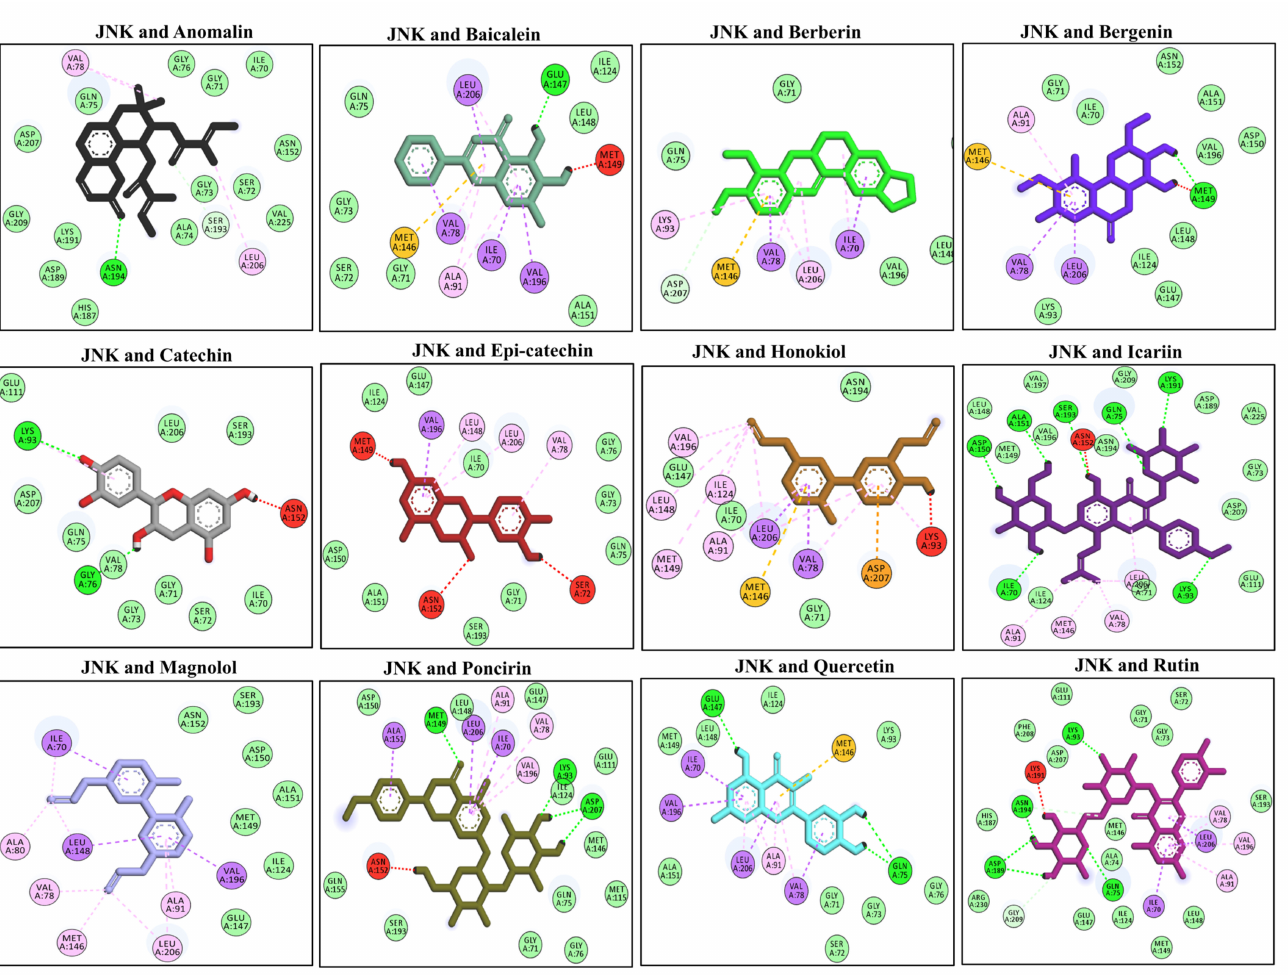
Figure 6. The molecular docking analysis of the selected compounds with the JNK receptor using AutoDock Vina software. The molecular docking showed binding of the studied ligand with the JNK via multiple hydrophilic and hydrophobic bonds. The ligand and protein interactions were visualized in Discovery Studio Visualizer_16 and ligands whose negative binding energy was high were